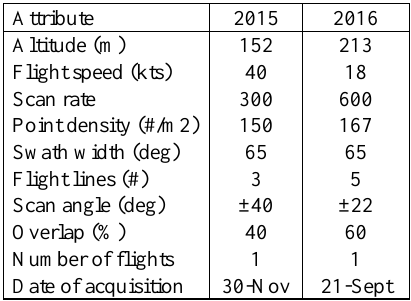
Table 2. Specifications of lidar acquisition